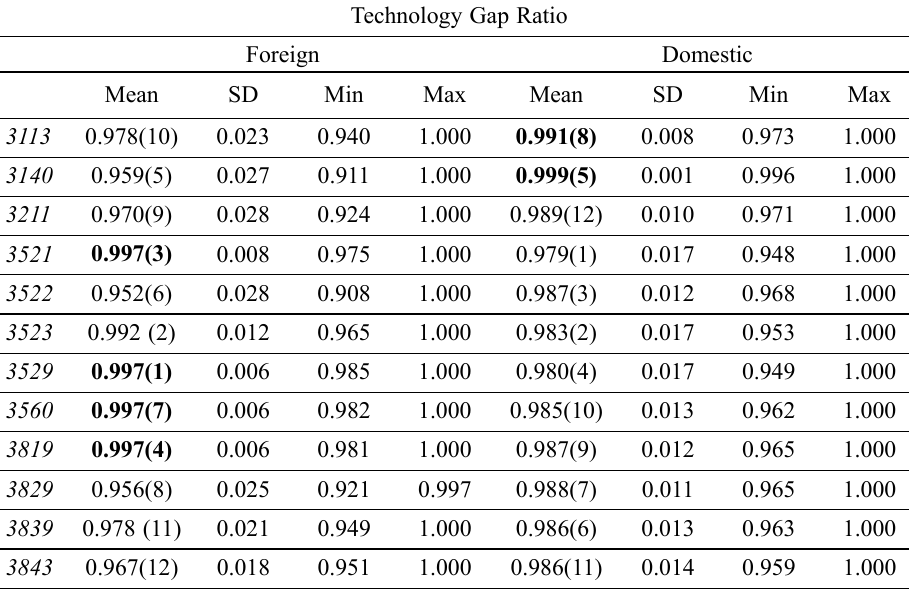
Table 4. Technology Gap Rations of Some Selected